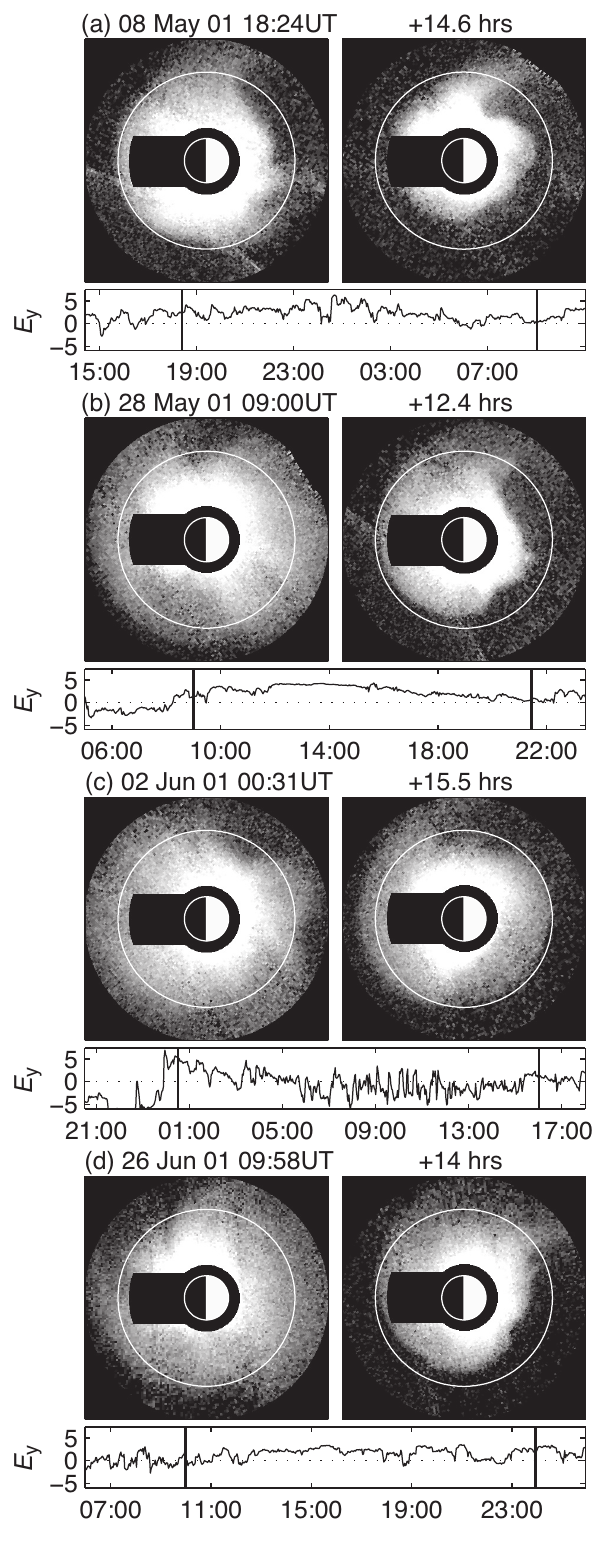
Fig. 2. Same as Fig. 1 for the other 4 study intervals.